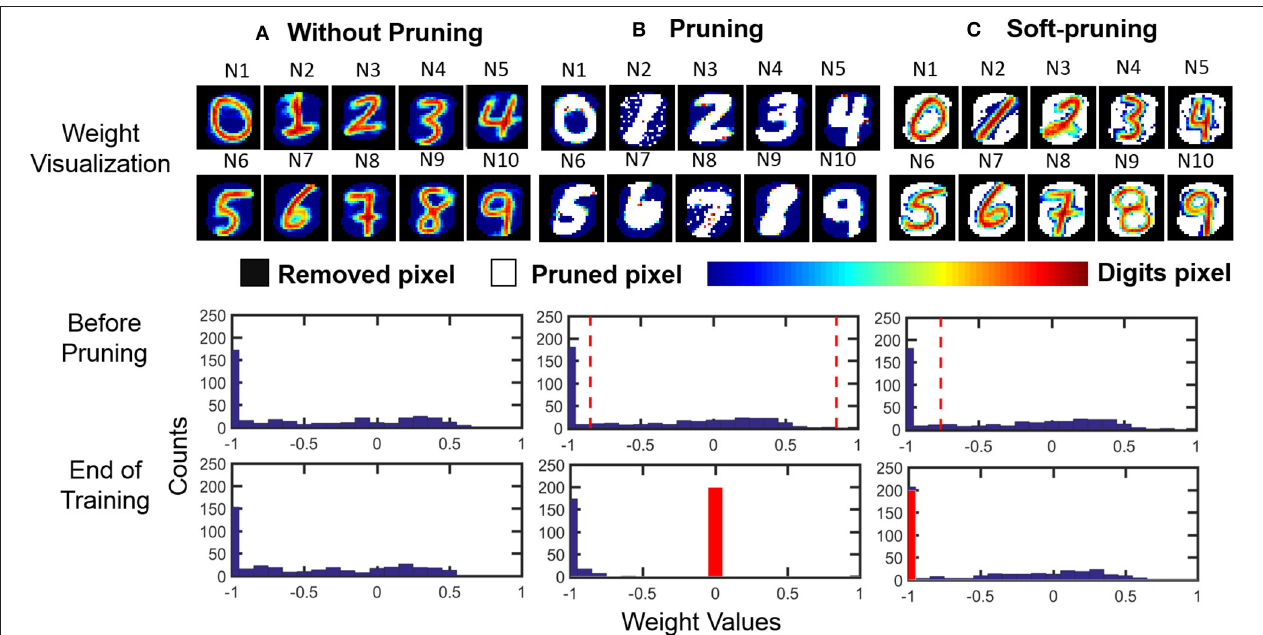
FIGURE 7 | Pruning example. (Top row) Weight visualization of the 10 representative output neurons after the SNN is trained in 3 different cases: (1) without pruning, (2) with pruning (while pruning 50% of the weights), and (3) with soft-pruning (while pruning 50% of the weights). (Middle row) Weight distribution of a representative output neuron (N3) before it is about to be pruned during training. (Bottom row) Weight distribution of the same output neuron at the end of training. It is worth to note that we only recover the removed pixels (black pixels) for visualizing the learned weights. Since those pixels are not used during training, histograms only include corresponding digit pixels (color bar) and pruned pixels (white pixels). (A) Without pruning, the STDP rule causes the weights for the MNIST dataset to follow a distribution where many of the weight values saturate at the lowest possible value. These low weights represent the background of MNIST training samples that are being learned by the SNN. (B) Pruning prunes the weights between the two dashed lines, which represent the 50% of the weights that centered about 0, and sets their values to 0 (red bar). (C) Soft-pruning prunes the weights to the left of the dashed line, which represent the 50% of the weights that are the lowest-valued weights, to the lowest possible value, which is at − 1 (red bar). For both pruning and soft-pruning, the weights that are not pruned continue to develop for the rest of